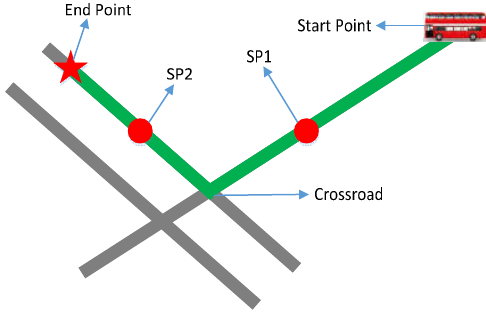
Figure 13. The results of global path planning.